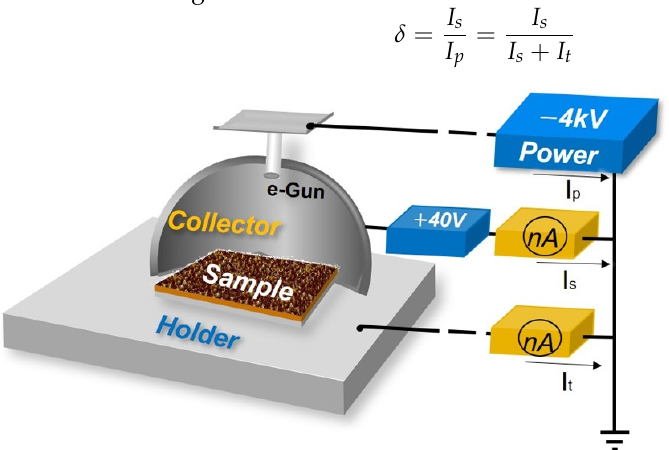
Figure 5. The sketch of SEY measurement system.